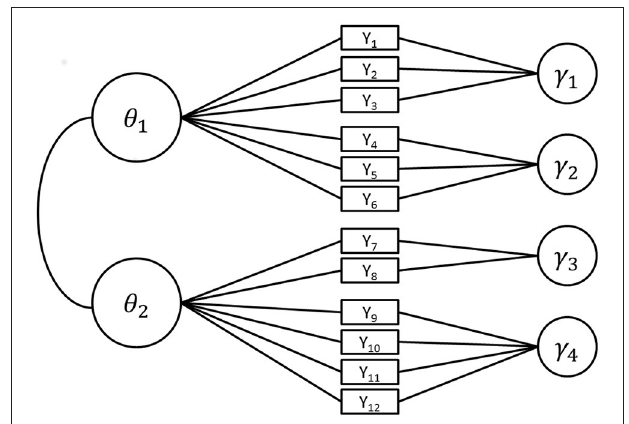
FIGURE 1 | Path diagram of the structure of a testlet model for 12 items (Y 1 to Y 12 ) each loading on one of two ability variables θ 1 and θ 2 . Every item belongs to exactly one of four testlets γ 1 to γ 4 . For identifiability, the means of all latent variables are set to 0 and the variances of θ 1 and θ 2 to